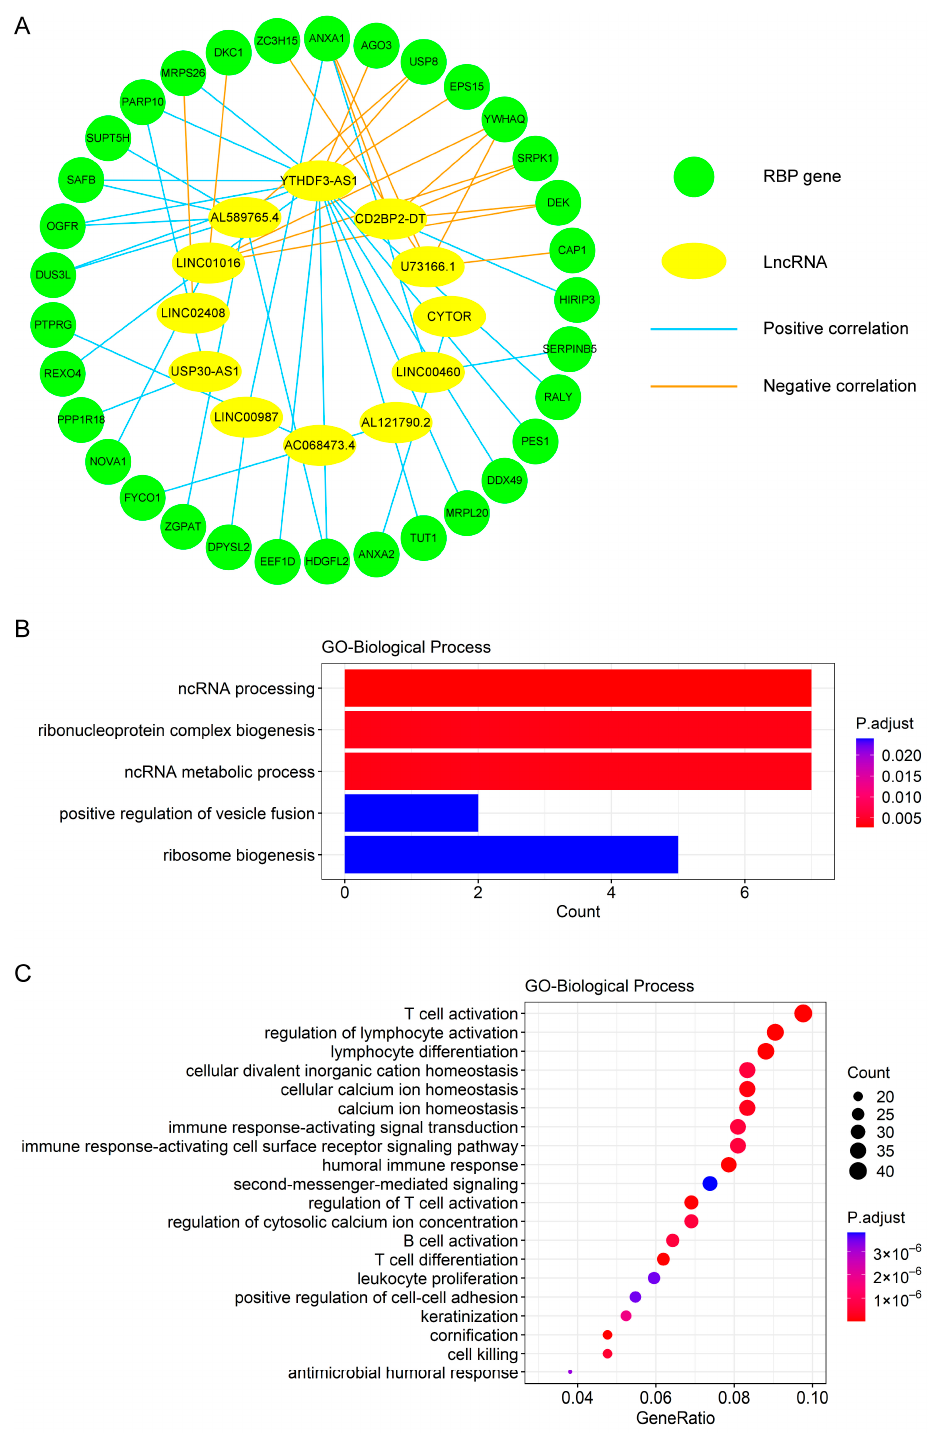
Figure 5. The co-expression network and GO enrichment analysis. ( A ) A co-expression network comprised of 12 lncRNAs in the prognostic signature and 33 RBP genes correlated to them. ( B ) The top 5 GO biological processes with the significant enrichment of the 33 RBP genes. ( C ) The top 20 GO biological processes with the significant enrichment of the differentially expressed genes between the high- and low-risk groups in the entire cohort.